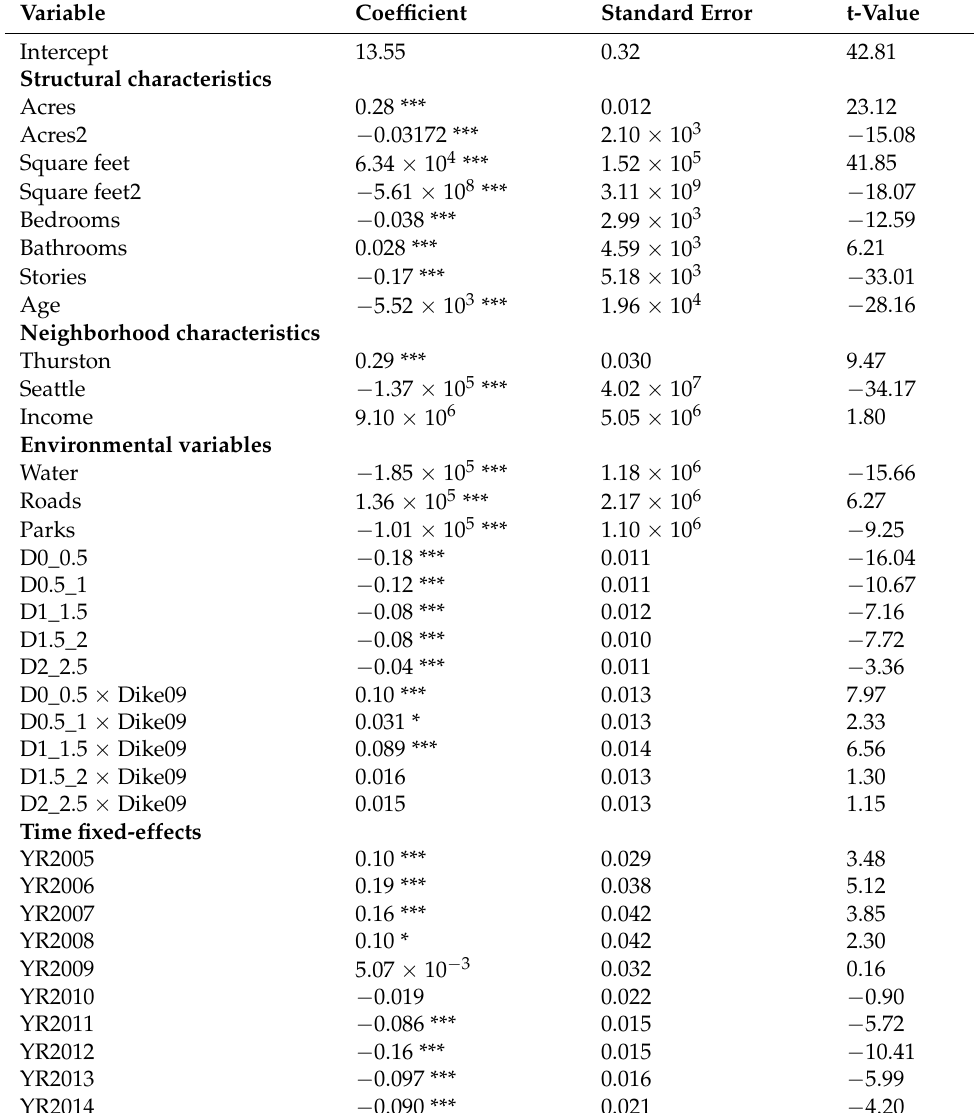
Table 3. Hedonic Pricing Model Regression